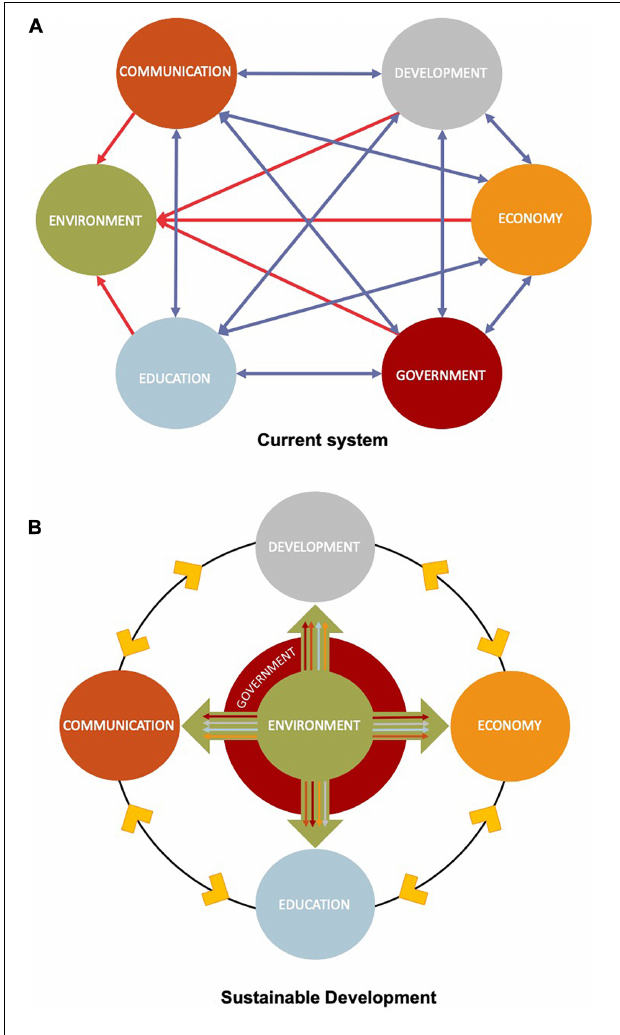
FIGURE 1 | Strategic development models have relied on the expolitation of the environment. Investing in blue natural capital and a sustainable future requires an evolution of the current development model ( Figure 1A ). A revised model needs to center the environment, valuving creation over destruction and regulating management through well-planned and executed governmental pollicies ( Figure 1B ). (A) In the current system, all sectors are interconnected but primairly linked to the environment through exploitation (red arrows). In this model there is a lack of acknowledgment of the impact of the environment on the success on the prosperity of any developmental project. Economic opportunities are therefore often missed, and the importance of the environment is undervalued. Thus the incentive towards protecting, preserving, and rebuilding the health of natural ecosystem is reduced. Consequently, finacial benefits and long-term growth are reduced and threatened. (B) The newly proposed environment centered (Sustainable) development model (presented here) aims to recognize the socio-economic importances of the environmental’s health on strategic development, by placing it at the center. The success and failure of each sector directly impacts the environment as well as indirectly itself and all others. When the environment is placed at the core of the system, the inter-connectivity of the sectors is clearly linked through the sustained health of eco-system – the environmental is effectively the heart of social and economic wealth. In this model governance is not a sector like any other; governments are fact of the key custodains of the natural environments. Government collaborations